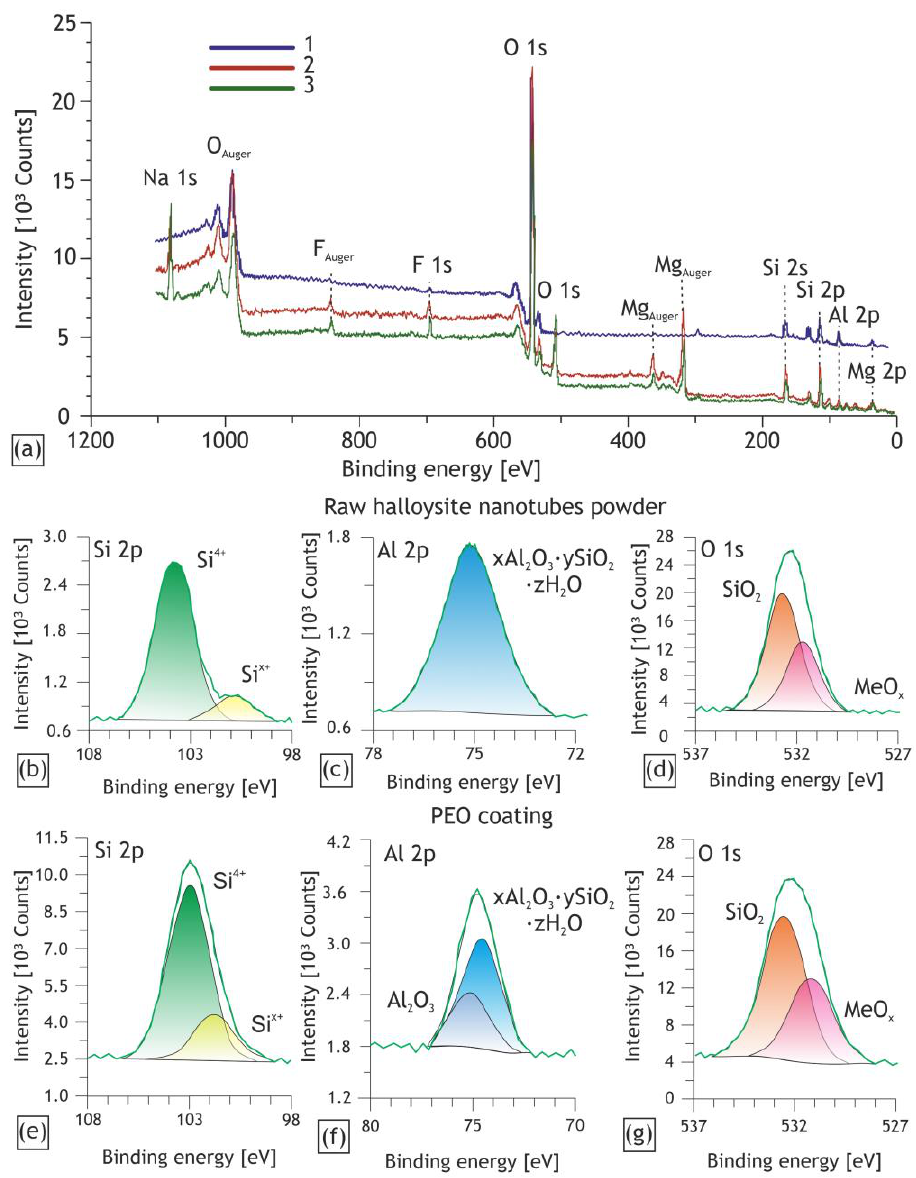
Figure 9. XPS survey spectra of the surface of the H40 coating: spectrum for raw HNTs powder (1), as-prepared H40 sample (2) and for the sample after 5 min Ar + etching (3) ( a ); high-resolution XPS spectra of O 1s ( b ), Si 2p ( c ), Al 2p ( d ) for the raw HNTs and O1s ( e ), Si 2p ( f ), Al 2p ( g ) for the H40 sample.